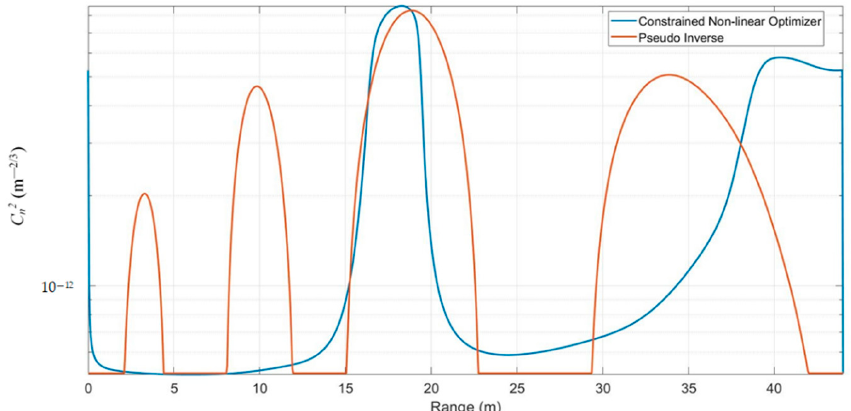
Figure 9. Turbulence profiles from the short-range imaging experiment. Profiles were derived from images captured at 20:05 local (UTC—5) on 15 November 2019.